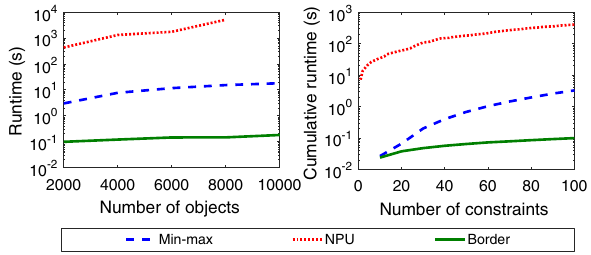
Fig. 9 Runtimes of different